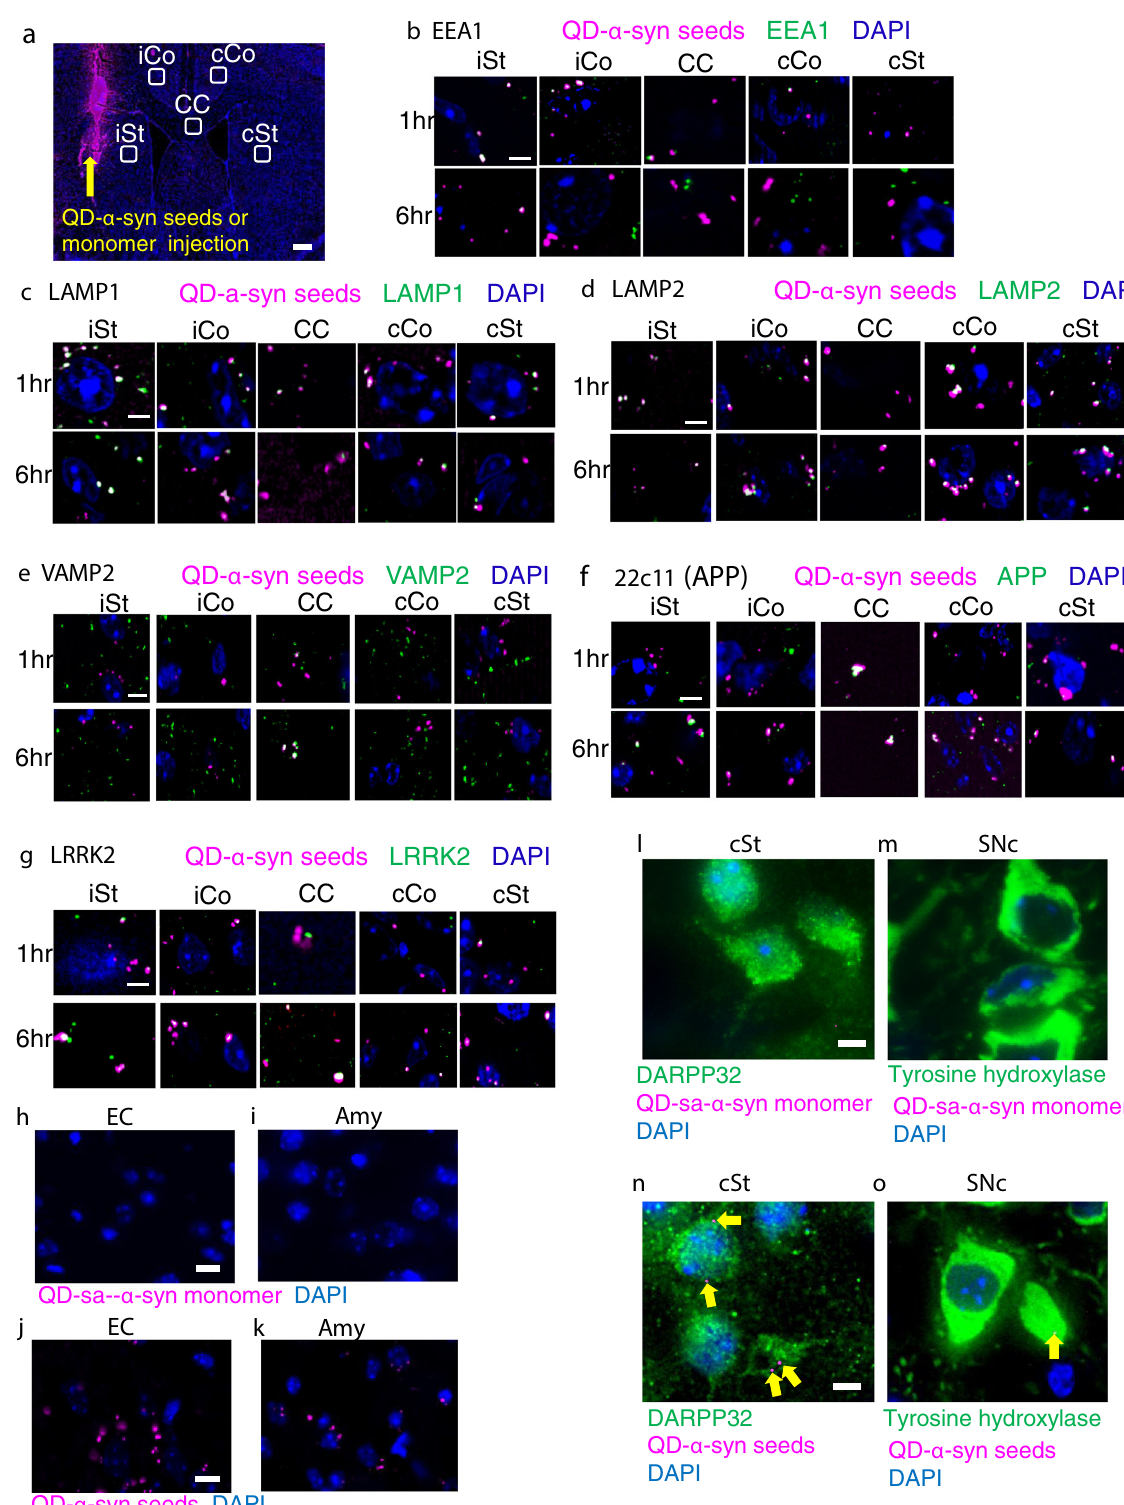
(Supplemental Fig. S5a and b) and QD-sa- α -syn seed migration in the living slice. Tracking analyses for QD-sa- α -syn monomer in the slice showed no migration signals in the contralateral ROI (Supplemental Fig. S5c, upper right panel), whereas α -syn seeds which were labeled with QD by the same method (QD-sa- α -syn seeds) migrated in the contralateral region. (Supplemental Fig. S5c, lower right